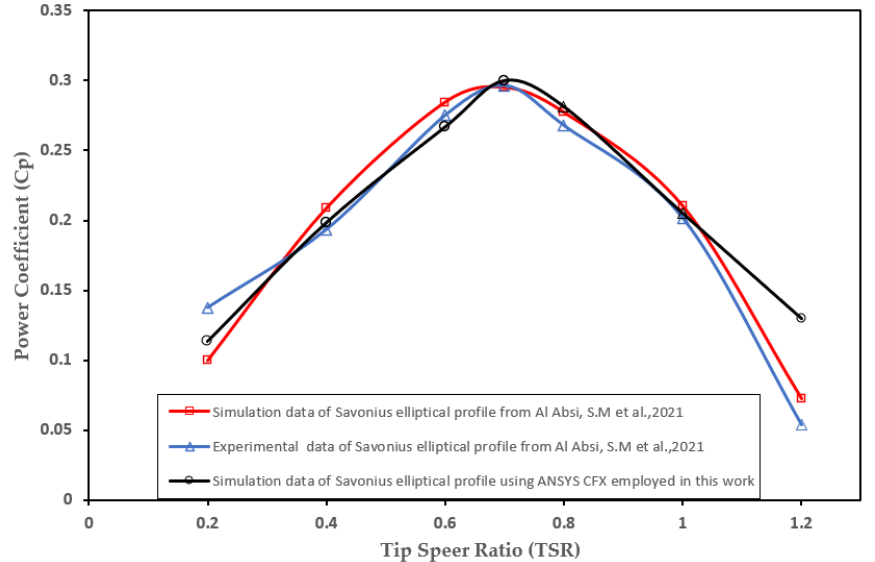
Figure 8. Numerical model verification using Cp versus TSR [48].